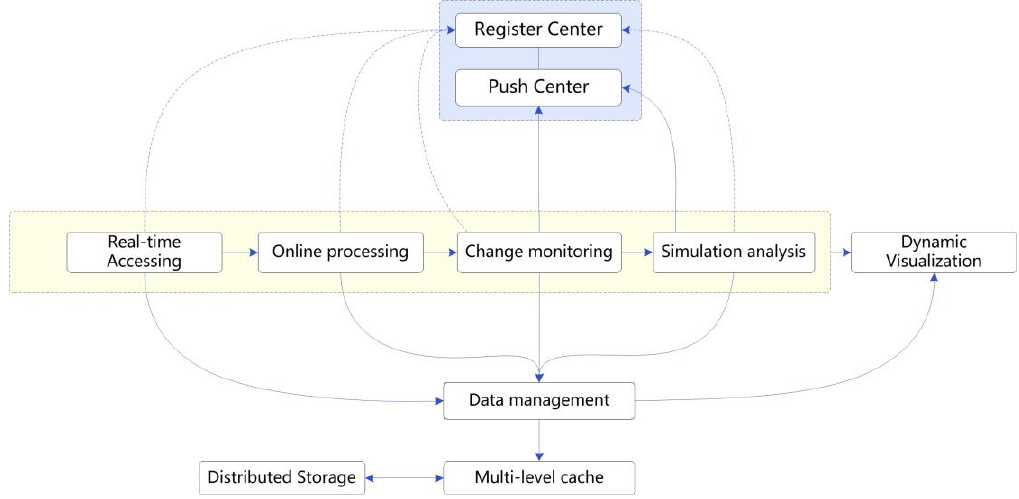
Figure 1. General running framework for RGIS